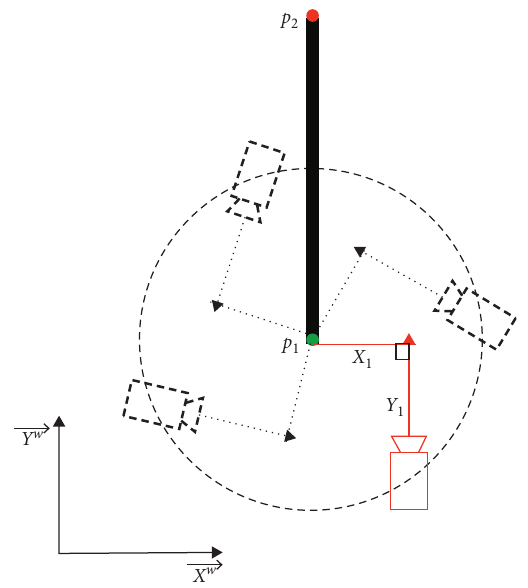
Figure 6: Relation between a lane endpoint and the estimated camera position.